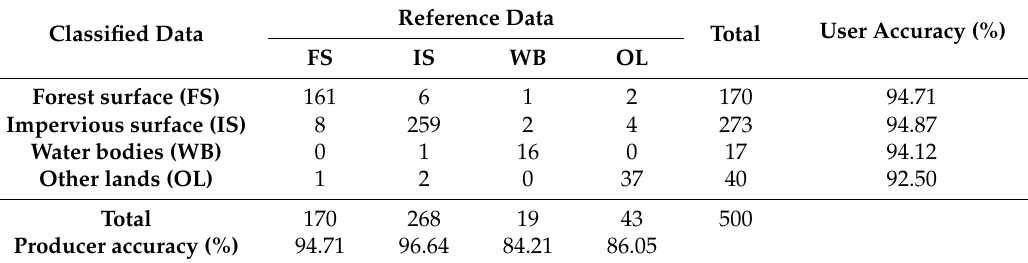
Table A3. Error matrix for the 2017 LULC